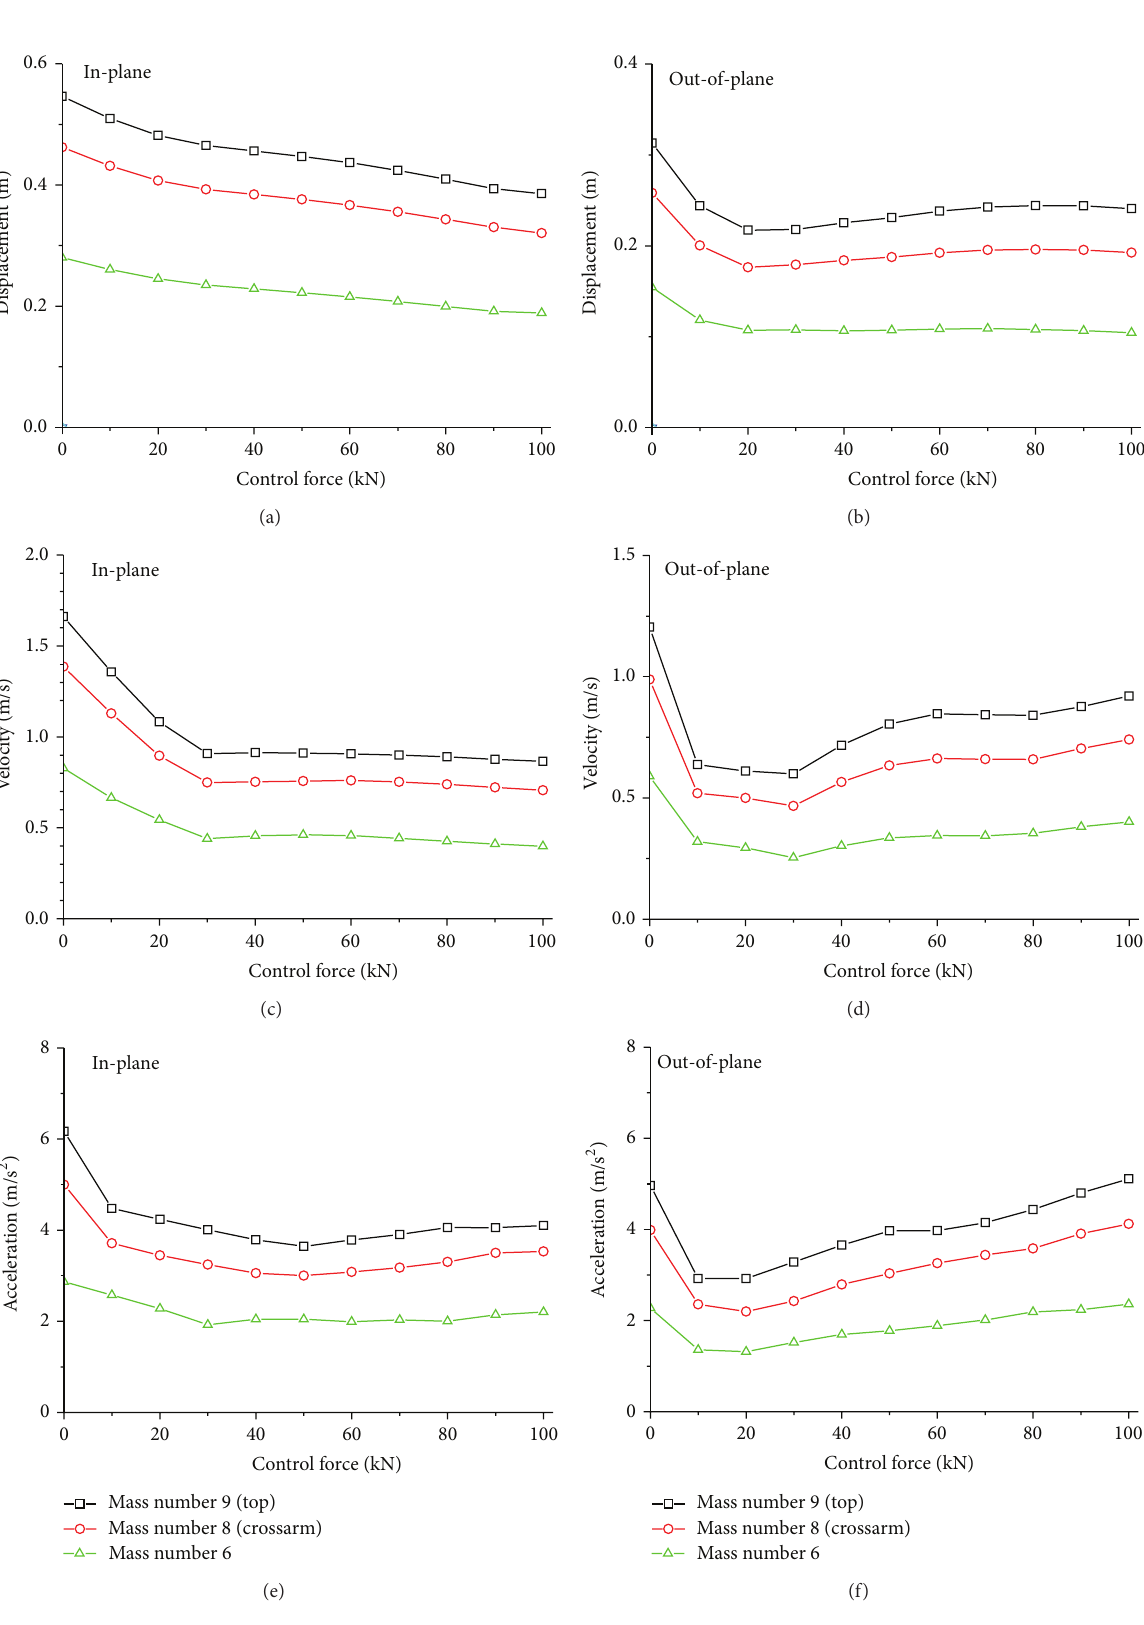
Figure 8: Variation of maximum responses with damper